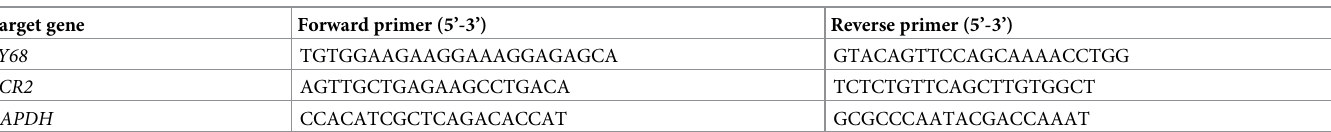
Table 2. qRT-PCR primer